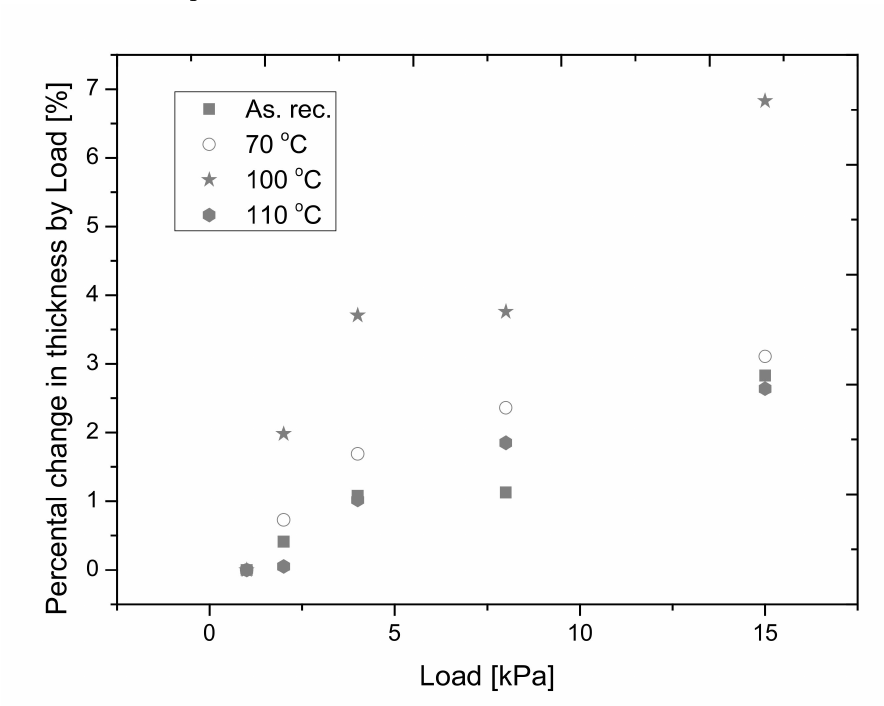
Figure 7. The changes in the thickness in the function of the applied